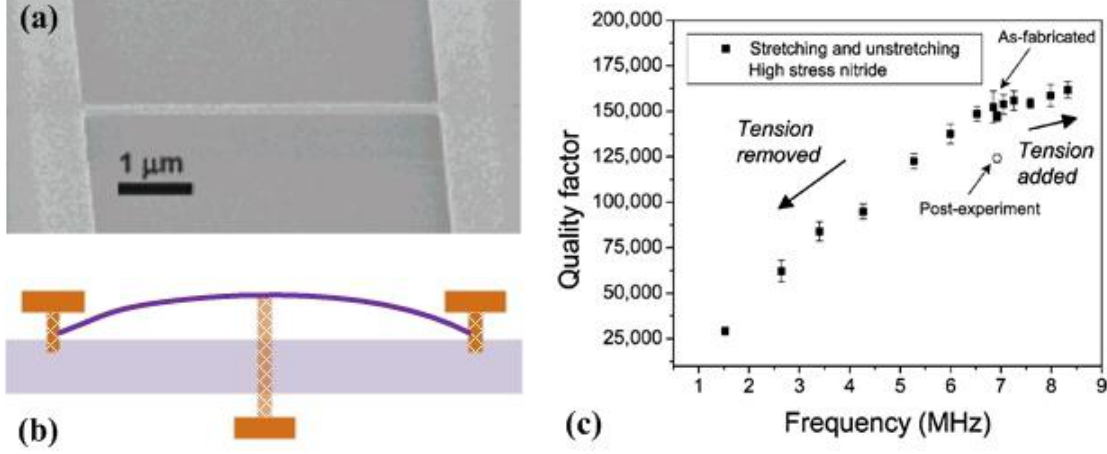
Figure 31. Stress tuning of resonant frequency of the doubly clamped beam resonator reported by Verbridge et al . [125]. ( a ) Doubly clamped beam resonator; ( b ) Schematic digram of the added tensile stress to the resonator; ( c ) Experimental results of added stress to tune both resonant frequency and quality factor. Reused with permission from [125], Copyright 2007, American Chemical